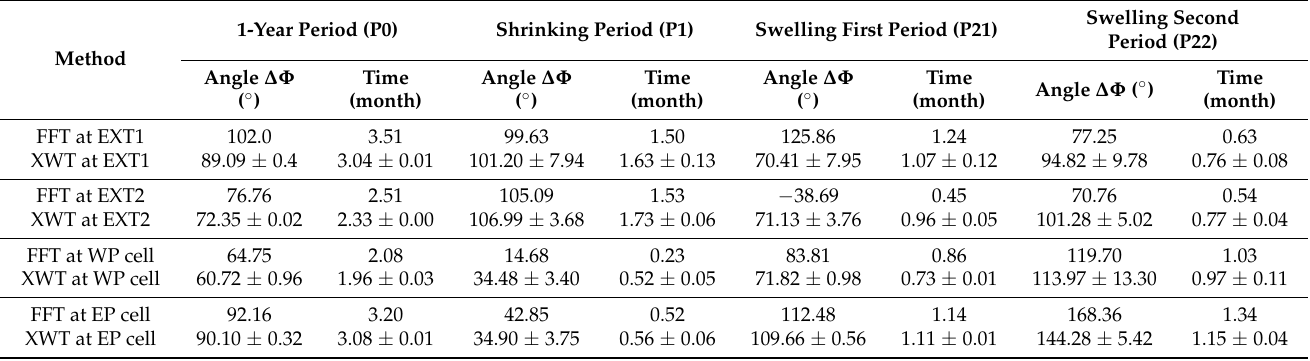
Figure 8. In the top, the cross wavelet transform (XWT) between SSM-ASC and two times series is shown: ( a ) EXT2 and ( b ) VERT-ASC-DES at WP. The relative phase relationship is shown as arrows, with in-phase pointing right and anti-phase pointing left and the Surface Soil Moisture leading by 90° pointing straight down. The Cone of Influence (COI) where edge effects might distort the picture is shown as a lighter shadow. In the bottom, the phase lags ΔΦ of SSM-ASC relative to the same times series are shown: ( c ) EXT2 and ( d ) VERT-ASC-DES at WP. The shrinking (P1*) and swelling (P21* and P22*) periods are found using the thick contours of XWT that designate the 5% significant level against red noise (see Materials and Methods section). Table 2. Comparison of Fourier FFT and cross-wavelet XWT analysis of phase angles and time lags of the surface soil moisture (SSM-ASC) relative to the vertical displacement at EXT1, EXT2, West Point (WP), and East Point (EP) for P0, P1, P21, and P22